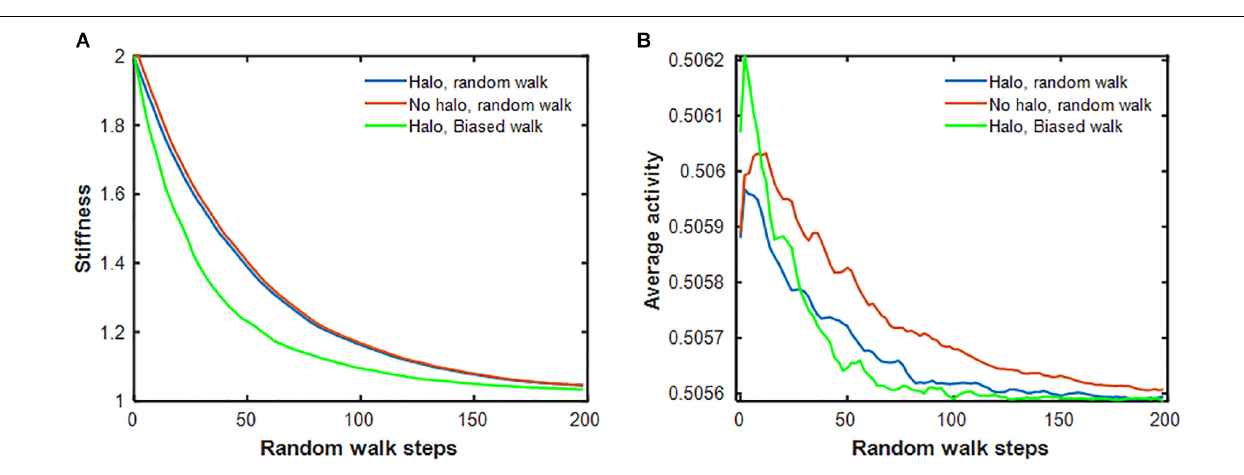
FIGURE 5 | (A) Stiffness decay of the central spring for 3 different models: halo formation allowed during pure random walk (blue), halo formation prohibited during pure random walk (red) and halo formation together with stiffness-biased random walk (green). (B) Average activity of 64 agents during the same simulations as in panel (A) . The activities were smoothed with a running average